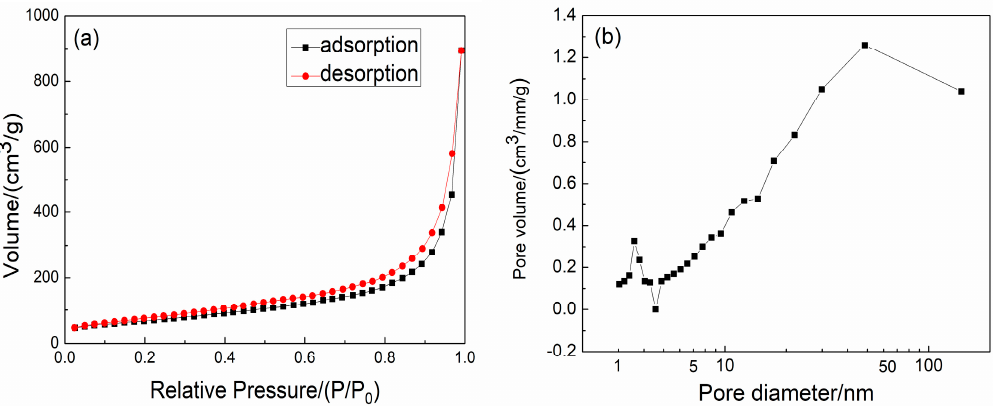
Figure 5. Nitrogen adsorption-desorption isotherm ( a ) and BJH pore size distribution ( b ) of SiBCO aerogel.